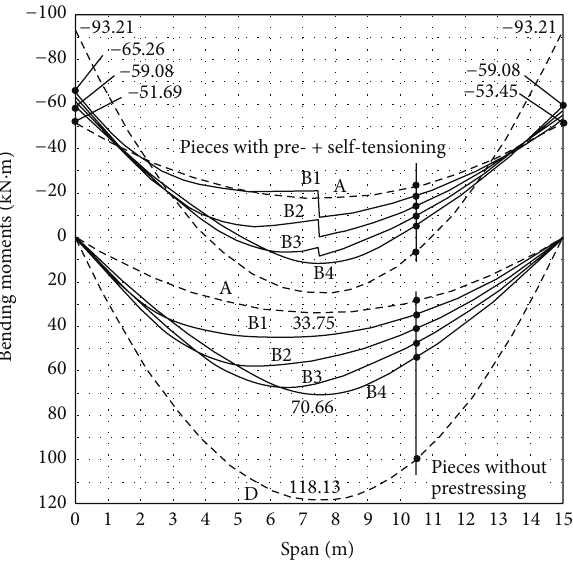
Figure 13: Bending moments hypotheses (A), (B1) to (B4), and (D) F4 structural floor type, sections (S1) and